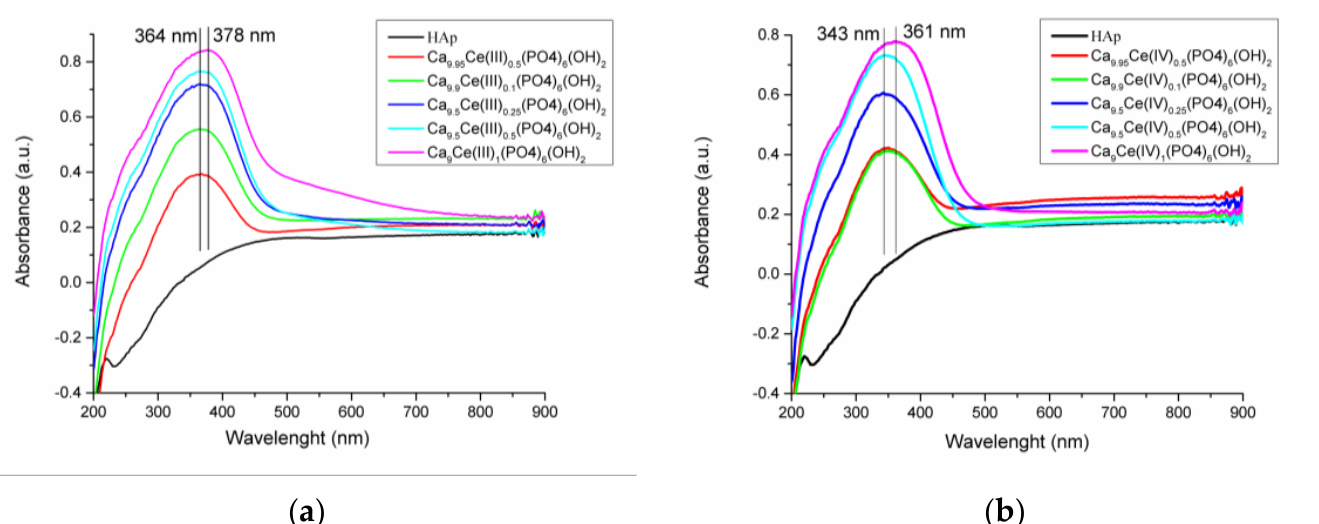
Figure 7. UV-Vis absorption spectra of ( a ) Ca 10 − x Ce(III) x (PO 4 ) 6 (OH) 2 and ( b ) Ca 10 − x Ce(IV) x (PO 4 ) 6 (OH) 2 with different con- centrations.